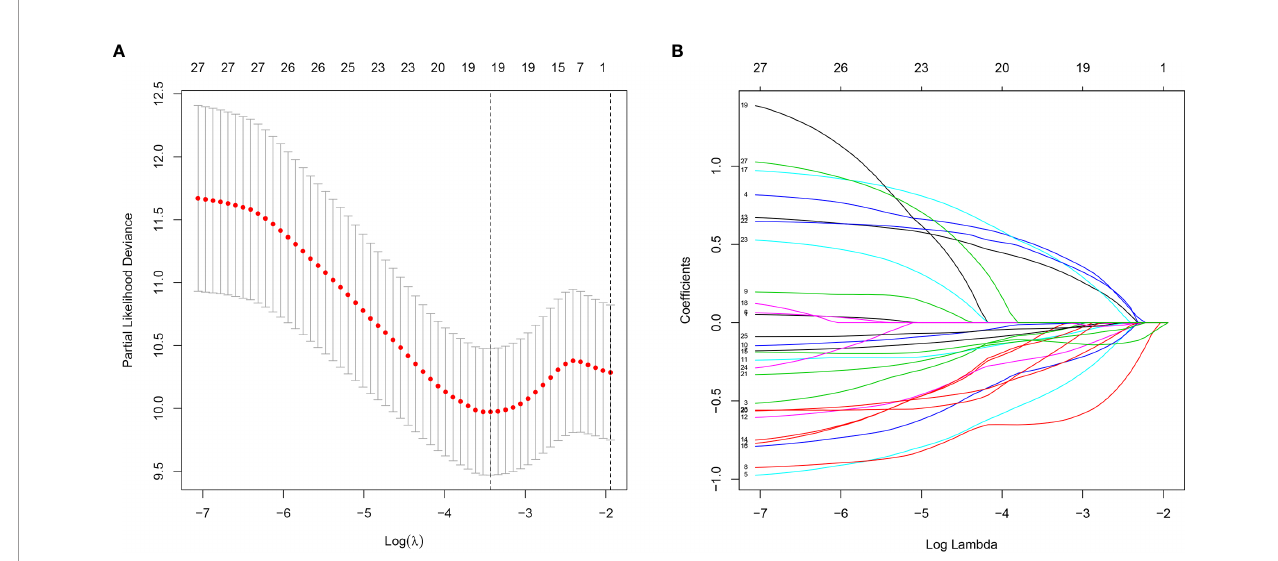
FIGURE 1 | Characterization of m6A-related lncRNAs signature. (A) The LASSO coef fi cient of 13 genes in GC. (B) Selecting the best parameters for GC on the basis of LASSO model ( l